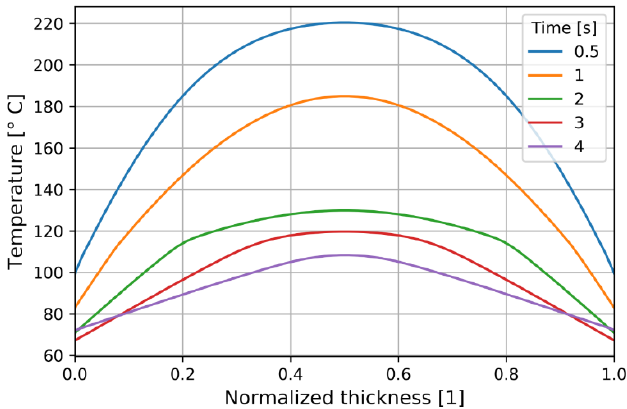
Figure 10. Temperature distribution at P2 through normalized thickness (dimensionless).